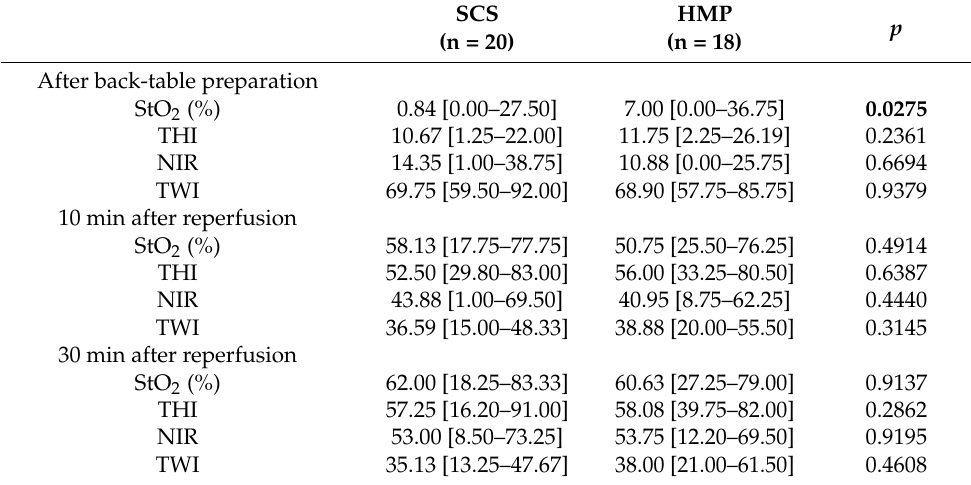
Table 4. HSI parameters stratified according to organ preservation method.